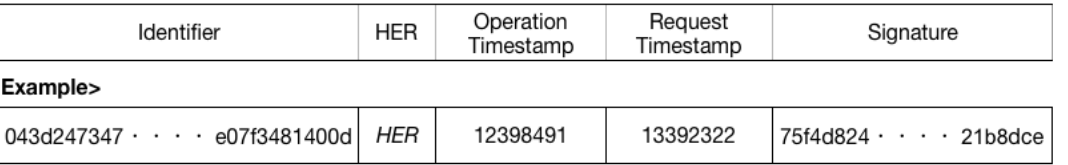
Figure 4. Hierarchy Edge Registration Request message format and example.